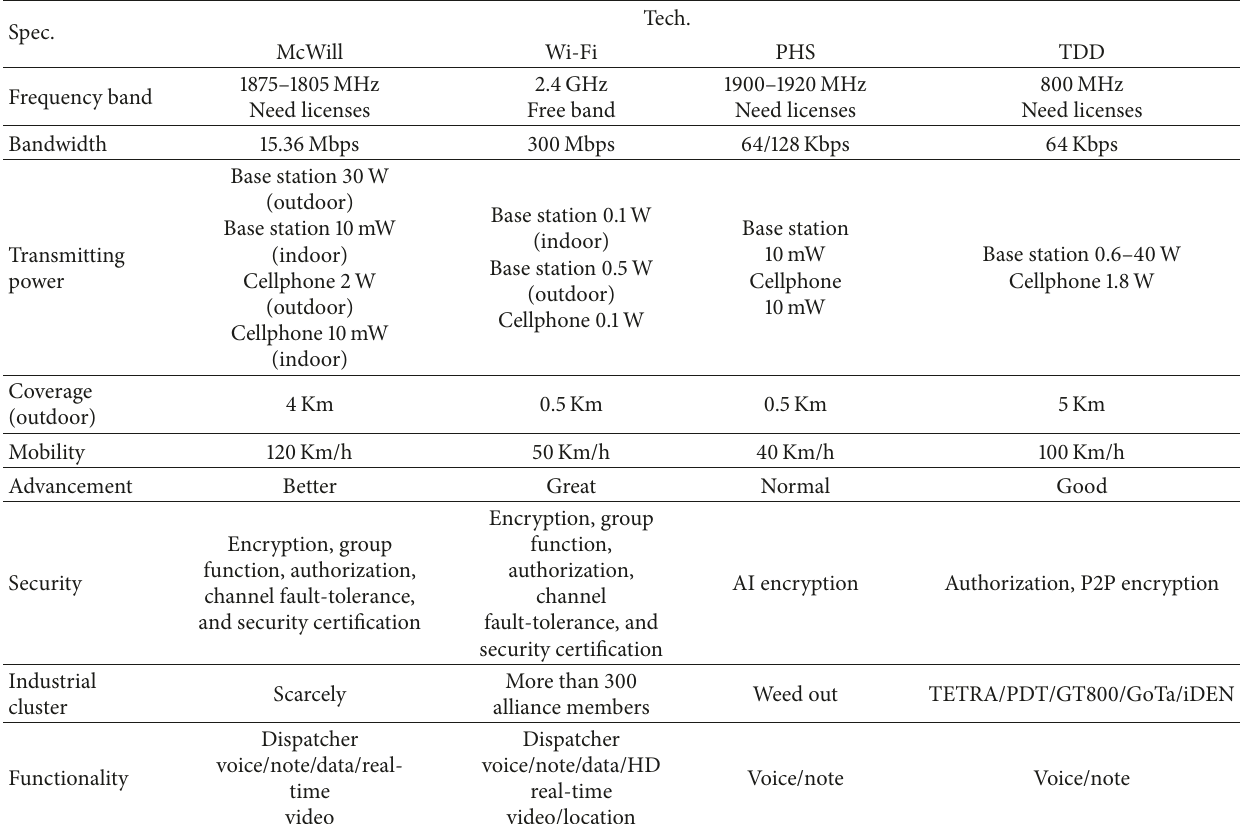
Table 1: Comparison of wireless standards in